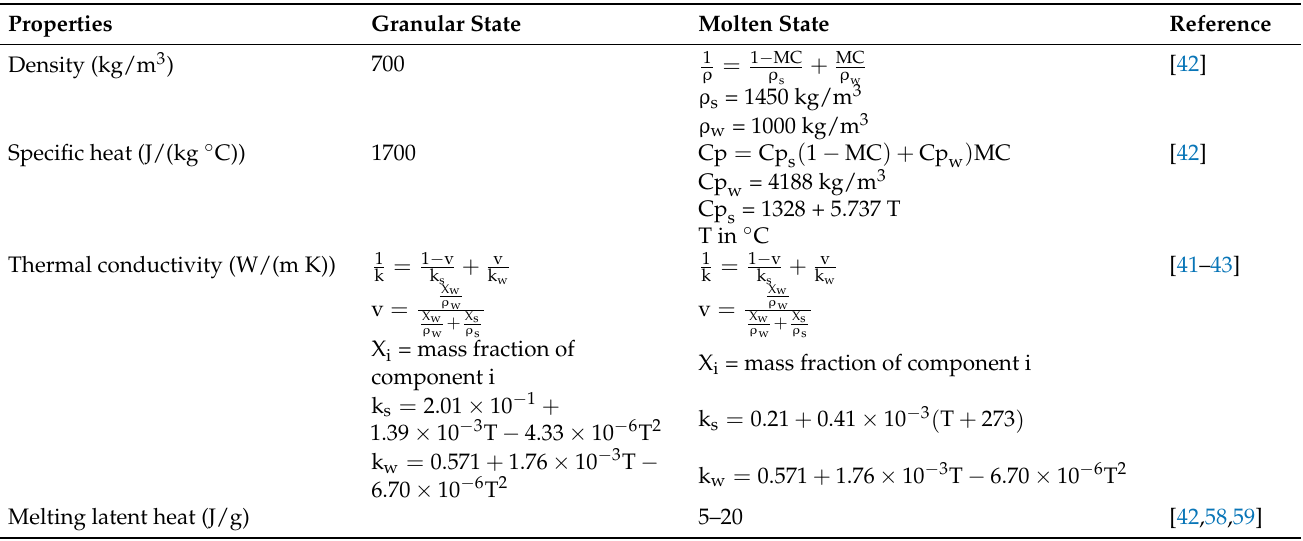
Table A1. Physical and thermal properties used in the extrusion simulation.